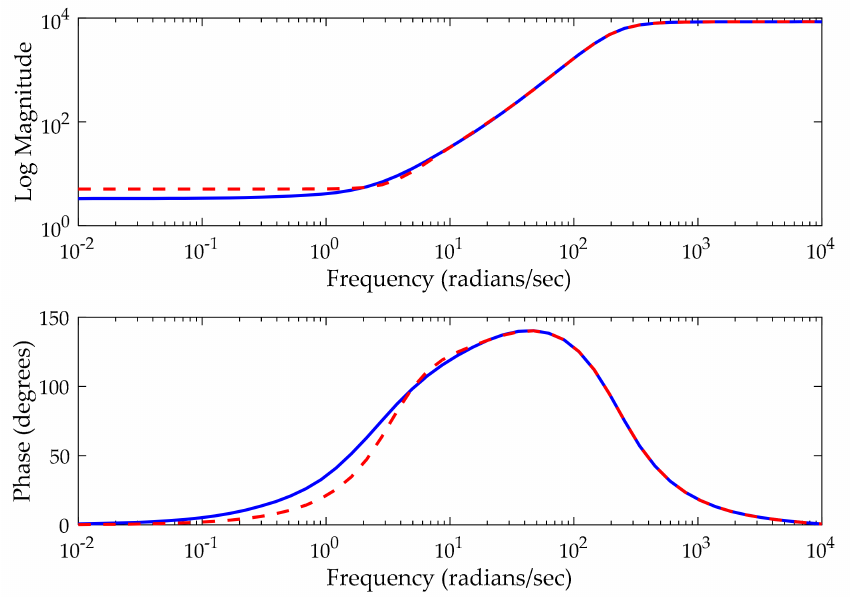
Figure 7. Bode diagram of the full-order controller (red) and reduced − order controller